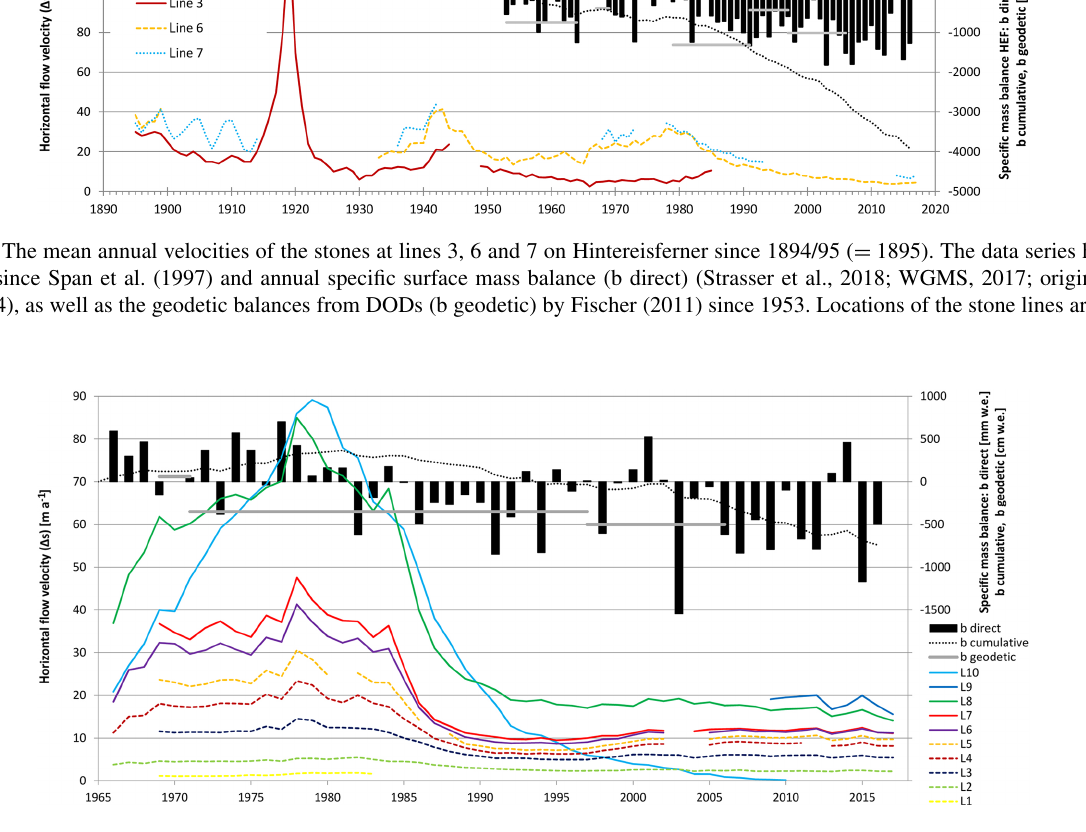
Figure 4. Annual horizontal flow velocities ( (cid:49)s/a ) at the accumulation and ablation stakes on Kesselwandferner (e.g. the year 2015 refers to the hydrological year 2014/2015) and the specific surface mass balance (b direct) (Strasser et al., 2018; WGMS, 2017), as well as the geodetic balances from DODs (b geodetic) by Fischer (2011). Locations of the stakes are shown in Fig.